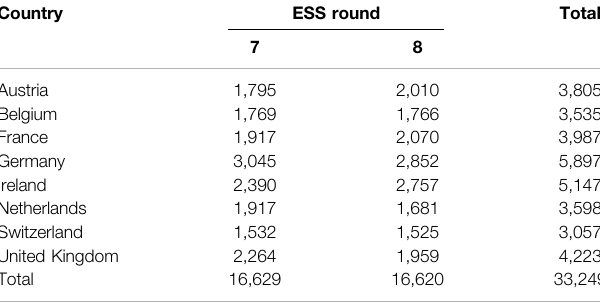
TABLE 1 | Sample sizes per ESS round and participating Western European country. Country ESS